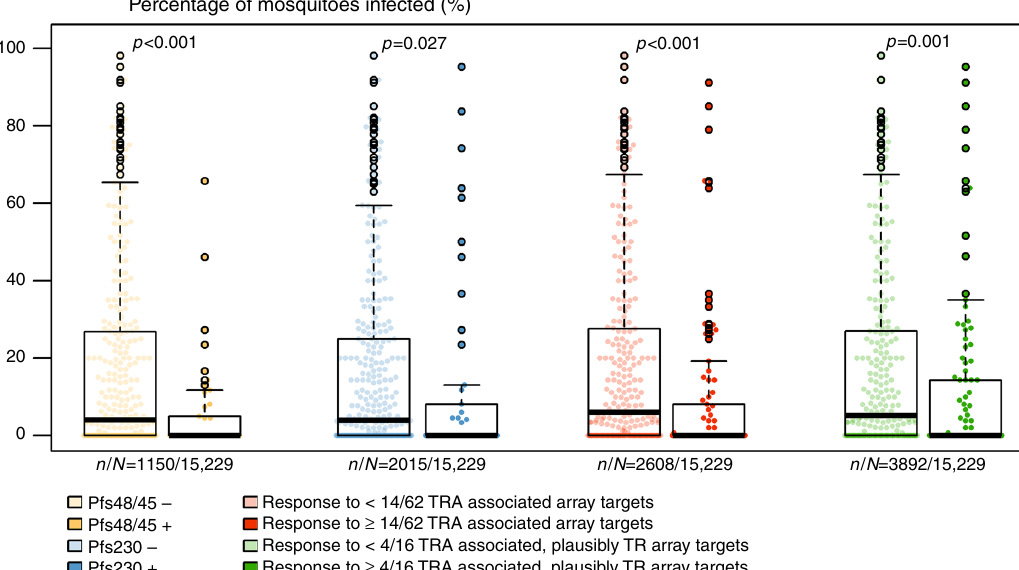
Fig. 3 Seroprevalence to Pfs48/45, Pfs230, and novel TRA-associated microarray proteins, and infectiousness in the direct membrane-feeding assay (DMFA). Individuals with DMFA data were categorised according to their possession of antibodies speci fi c to: Pfs48/45 (positive (+)/negative ( − )); Pfs230 (positive (+)/negative ( − )); ≥ 14 of the 61 novel microarray proteins with TRA-associated antibody responses (14 being the 75th percentile of the breadth of response to these microarray targets among the entire sample set); ≥ 4 of the 16 novel microarray proteins with TRA-associated antibody responses that are also plausible targets of antibodies with TRA (4 being the 75th percentile of the breadth of response to these microarray targets among the entire sample set). a Bars show the proportion of infectious individuals among seropositive/seronegative gametocytaemic individuals with DMFA data, with Clopper – Pearson con fi dence intervals. n / N = number of individuals seropositive/total number of individuals with DMFA data. P -values are from logistic regression, with adjustment for gametocyte density. b Boxplots show the percentage of mosquitoes that became infected after feeding. n / N = the number of mosquitoes feeding on seropositive individuals/the total number of mosquitoes feeding on individuals with DMFA data. p -values are from logistic models, adjusted for gametocyte density and with host (individual the mosquitoes were feeding upon) as a random effect. For all boxplots, outliers are shown as hollow black circles, whereas all data points are shown as solid coloured